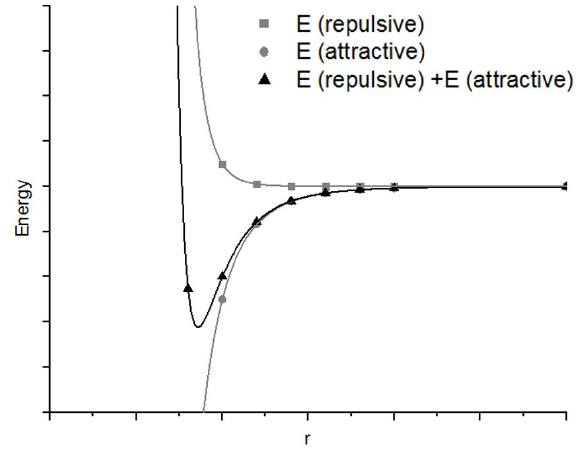
Figure 11. Lennard Jones potential (adapted from [76]).